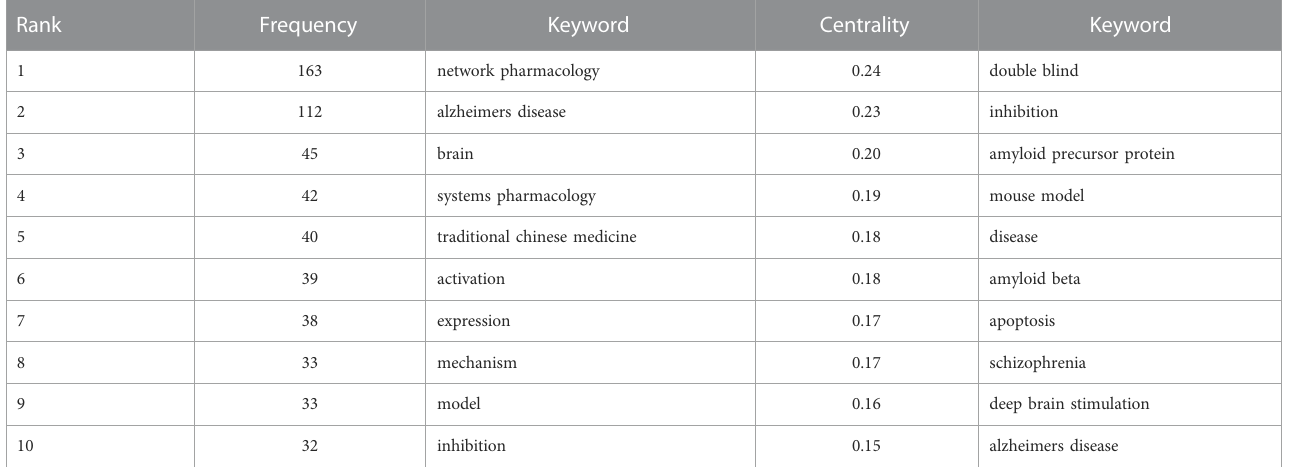
TABLE 7 Top 10 keywords by frequency and